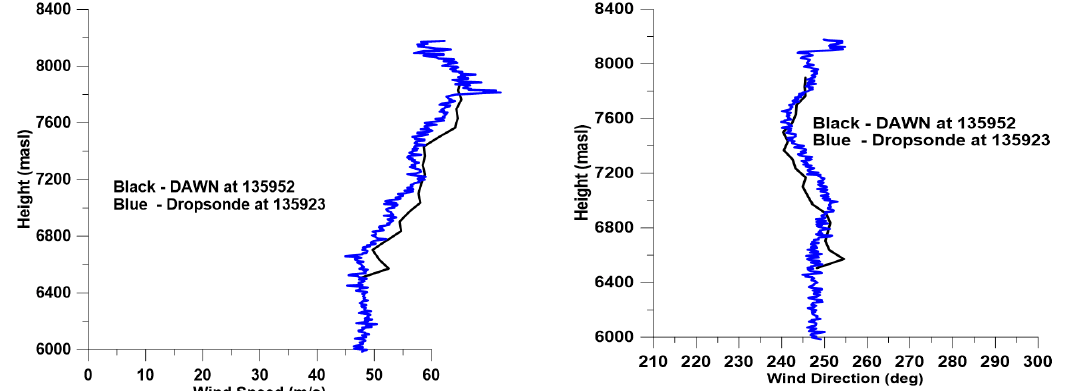
Figure 26. DAWN and dropsonde profiles of wind speed ( left ) and wind direction ( right ) around 1359Z on 19 May 2015.